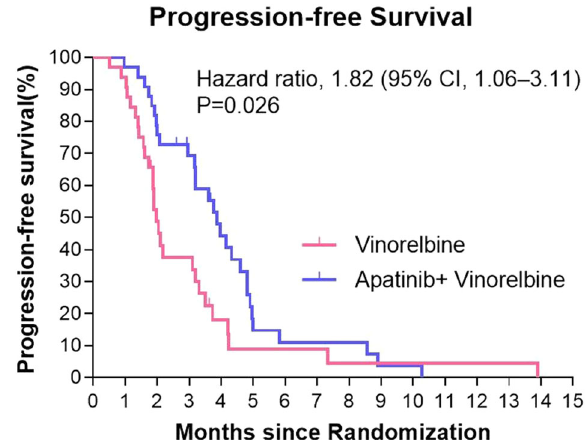
Fig. 2 Kaplan – Meier Estimates of Progression-free Survival among patients in the vinorelbine group and apatinib plus vinorelbine